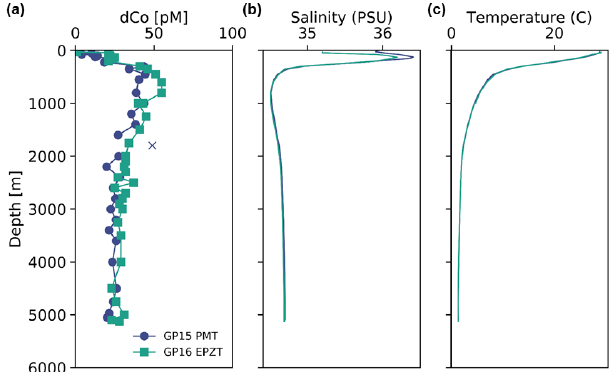
Figure 2. (a) Dissolved Co, (b) salinity and (c) temperature pro- files from a crossover station between the GEOTRACES GP15 Pa- cific Meridional Transect (PMT; November 2018; navy) and the GEOTRACES GP16 East Pacific Zonal Transect (EPZT; Decem- ber 2013; teal) at 10.5 ◦ S, 152 ◦ W. Outliers are marked with an